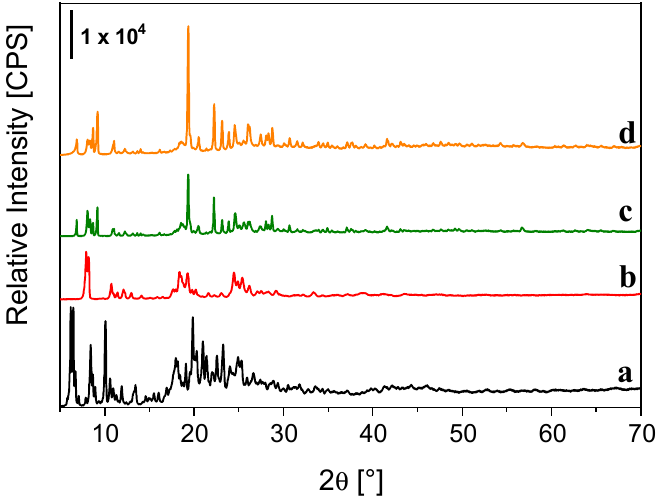
Figure 3. X-ray powder diffraction profiles of PhPOSS (a), the commercial condensed OctaPhenyl POSS (b), Tb-PhPOSS (c) and TbEu-PhPOSS (d). The diffractograms were collected in the 5–70° 2 θ range.